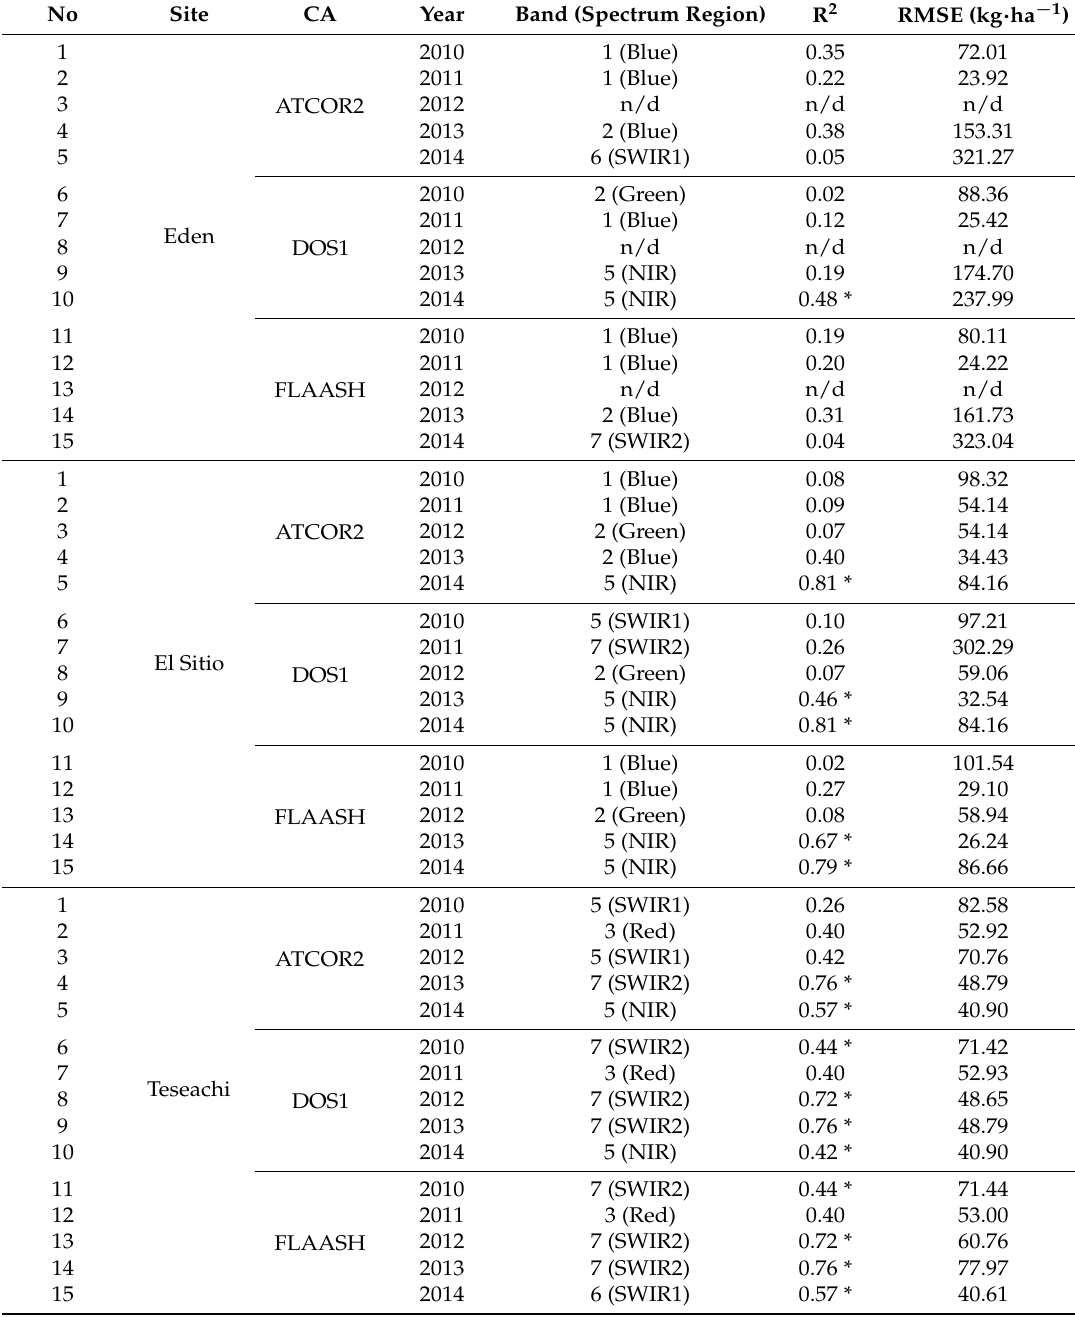
Table 2. Accuracy of the correction methods in the three permanent monitoring sites (PMS). The column of Band (spectrum region) corresponds to the spectral bands and the corresponding spectrum region that contributed the most for the biomass